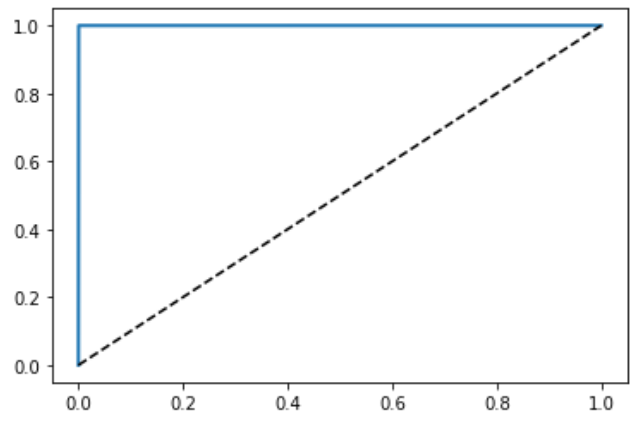
Electronics 2023 , 12 , x FOR PEER REVIEW Figure 27. Increasing the DDoS dataset ROC. Figure 27. Increasing the DDoS dataset ROC. Figure 27. Increasing the DDoS dataset ROC.